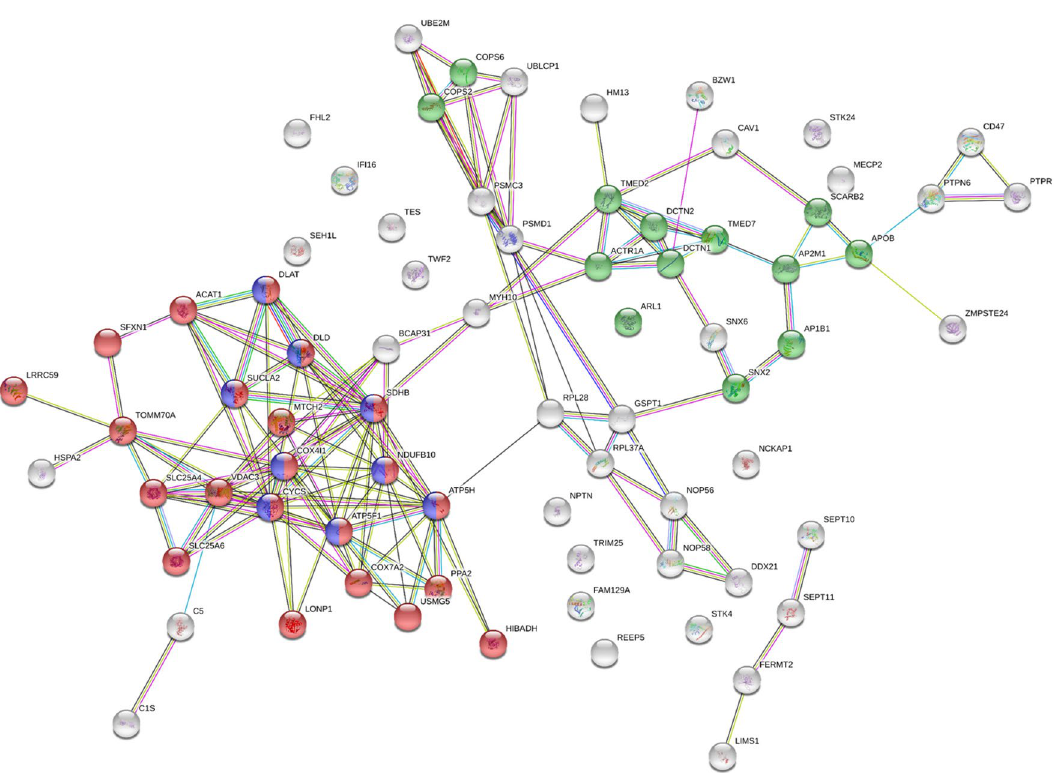
Figure 2. STRING diagram representing protein interaction pathway derived from the 77 proteins quantified in at least 80% of OCT and in none FFPE samples. The average local clustering coefficient as reported by STRING is 0.478. Proteins in blue belong to the TCA cycle and respiratory electron transport and proteins in green belong to the Membrane Trafficking (Reactome Pathways). Proteins in red belong to the Mitochondrial part (Cellular Component GO). Obtained from STRING v11 web-based software (https:// string- db. (n = 4 for T2/T3 and n = 5 for Ta/T1) were compared. The number of overlapping proteins was found to be in general slightly less than the number of quantifiable ones in FFPE samples, varying from around 400 to 1000